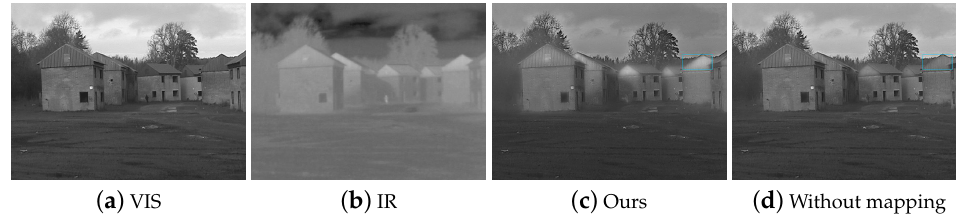
Figure 12. The roof of the building in the IR image is bright and in the VIS image is